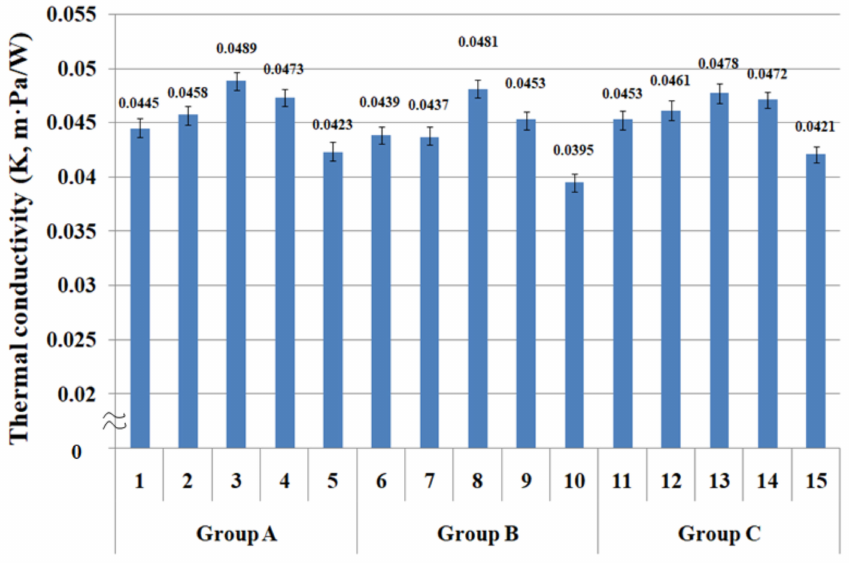
Figure 7. Thermal conductivity of the fabric